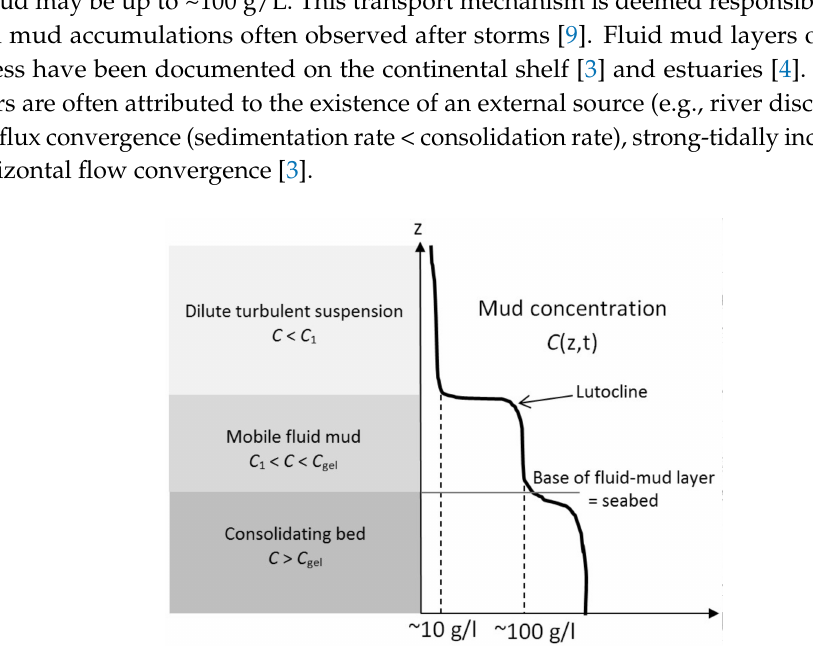
Figure 1. Schematic description of mud suspensions. Adapted from